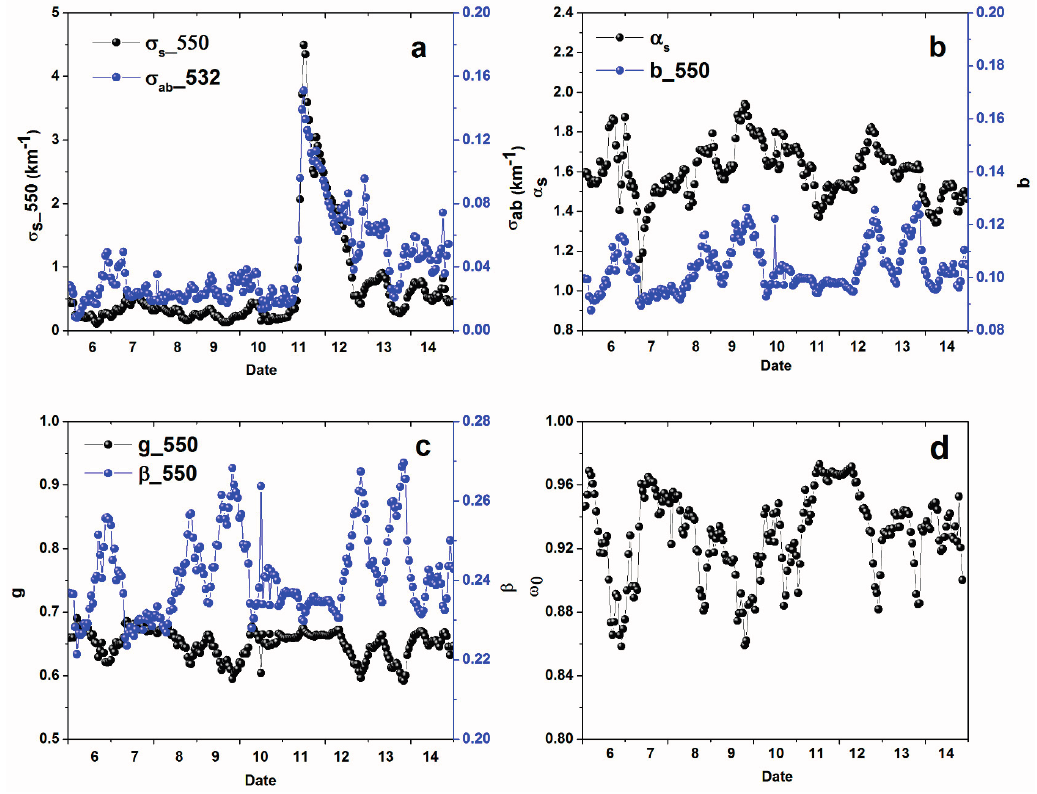
Figure 4. Time series variations of aerosol optical properties during haze at LIESMARS site during 6–14 June 2012. ( a ) Aerosol total scattering coefficient σ 550 (km − 1 ) at s_ 532 (km − 1 ) at 532 nm; ( b ) Scattering wavelength of 550 nm and absorption coefficient σ ab_ Ångström exponents α and backscatter ratio b 550 at wavelength of 550 nm; ( c ) Up-scatter s _ fraction β 550 and asymmetry parameter g 550 at wavelength of 550 nm; and ( d ) SSA ω _ _ 0 at wavelength of 532